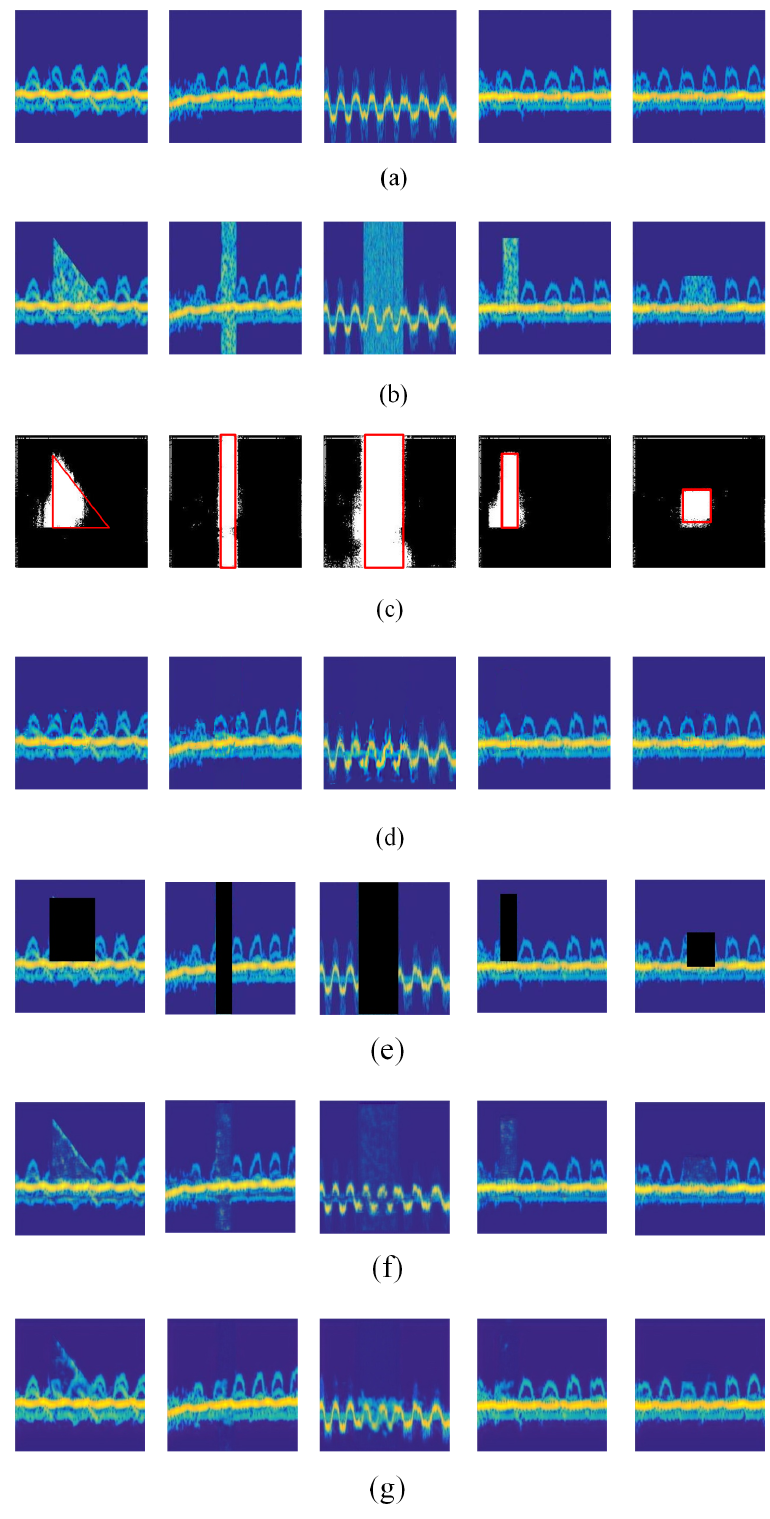
Figure 5. Results of the proposed method and three state-of-the-art methods on the simulated data. ( a ) The clean radar spectrograms. ( b ) The spectrograms with diverse interference. ( c ) The locations of interference detected by the proposed FCN model. The red boxes represent the ground truth of the locations of interferences. ( d ) The radar spectrograms restored with our method. ( e ) The spectrograms restored with Zeroing . ( f ) The spectrograms restored with FCNs . ( g ) The spectrograms with restored ResNet